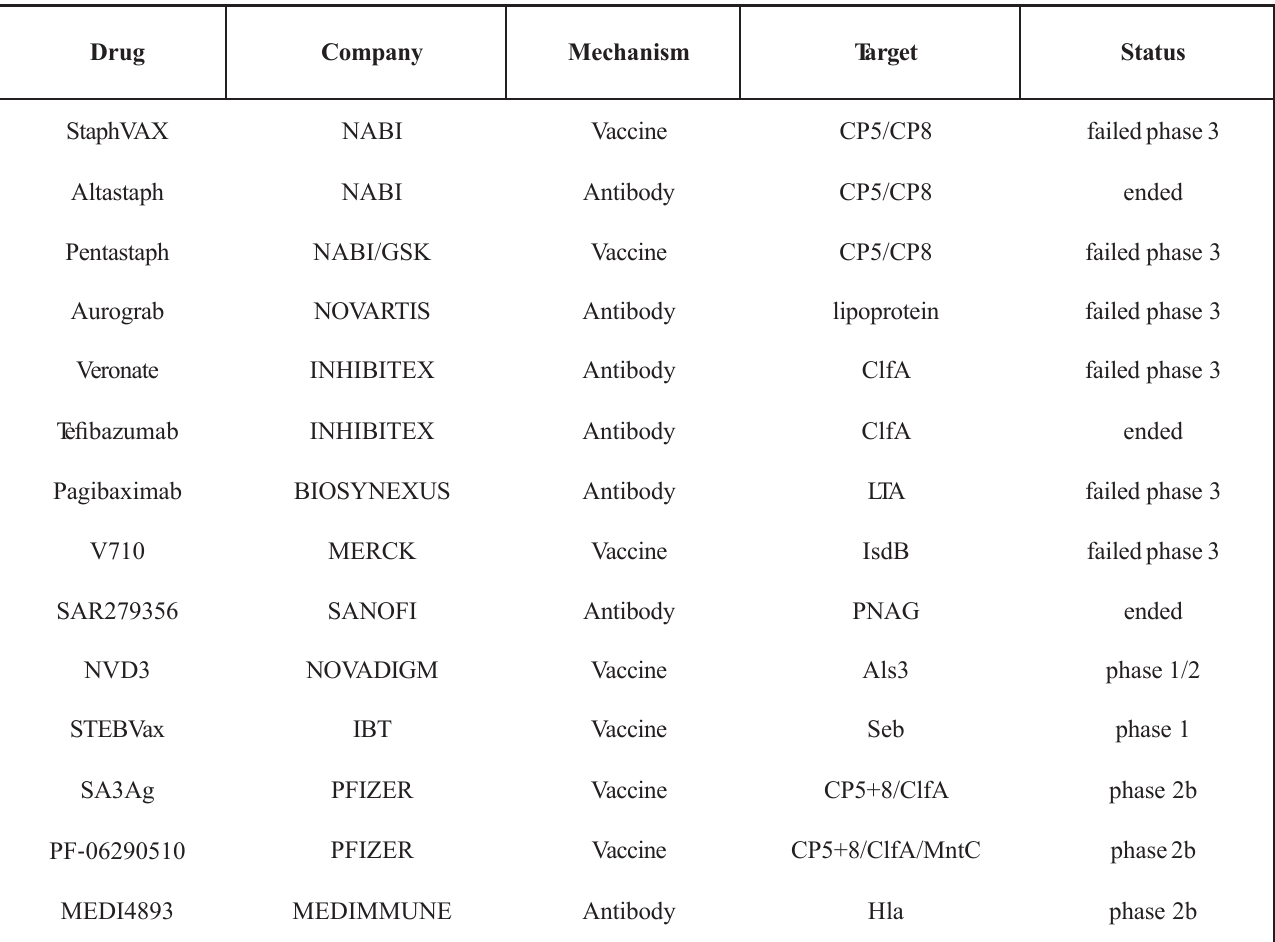
Table 3. Vaccine candidates against MRSA infections